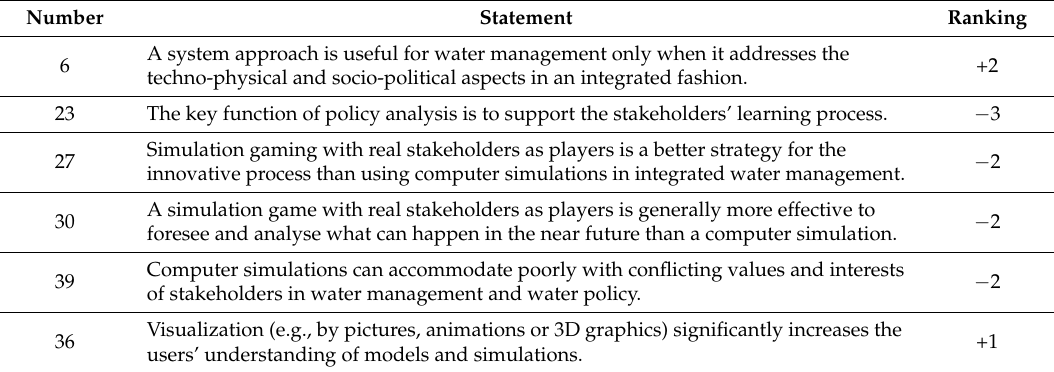
Table 8. Distinguished statements about MSG in frame